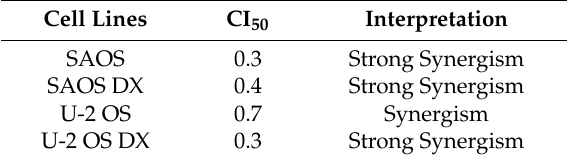
Table 7. CIs values between Doxo and Zol on wild-type and Doxo-resistant SAOS and U-2 OS